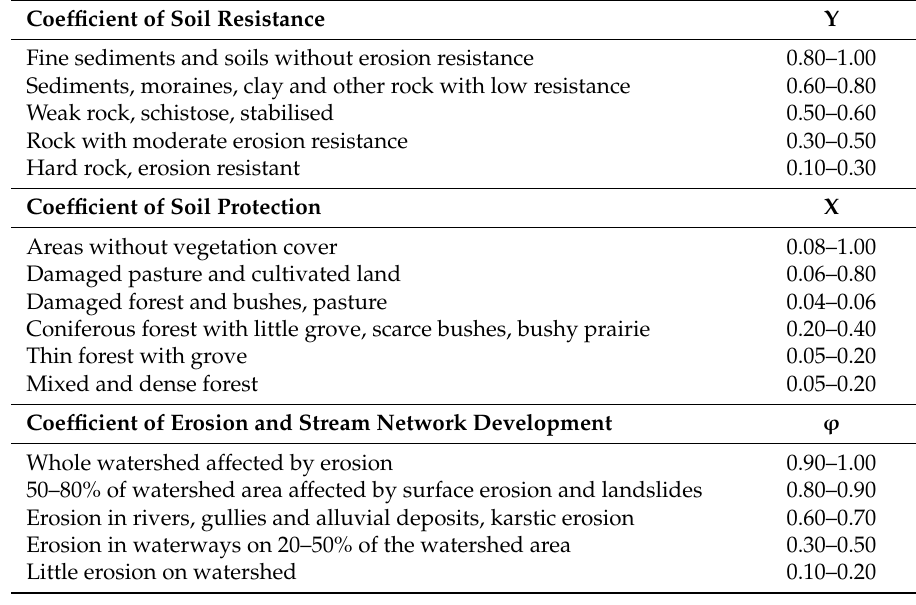
Table 3. Classification of erosion coefficient (Z) and specific annual gross erosion (W 0